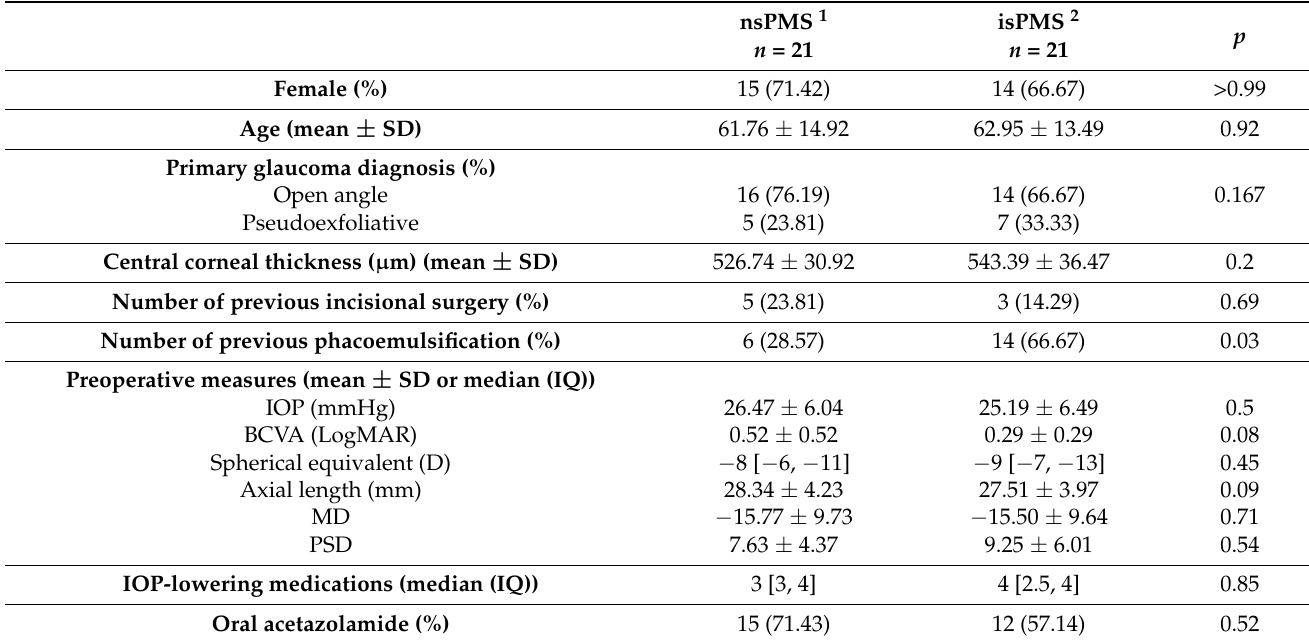
Table 1. Baseline demographics and clinical characteristics of the study population.